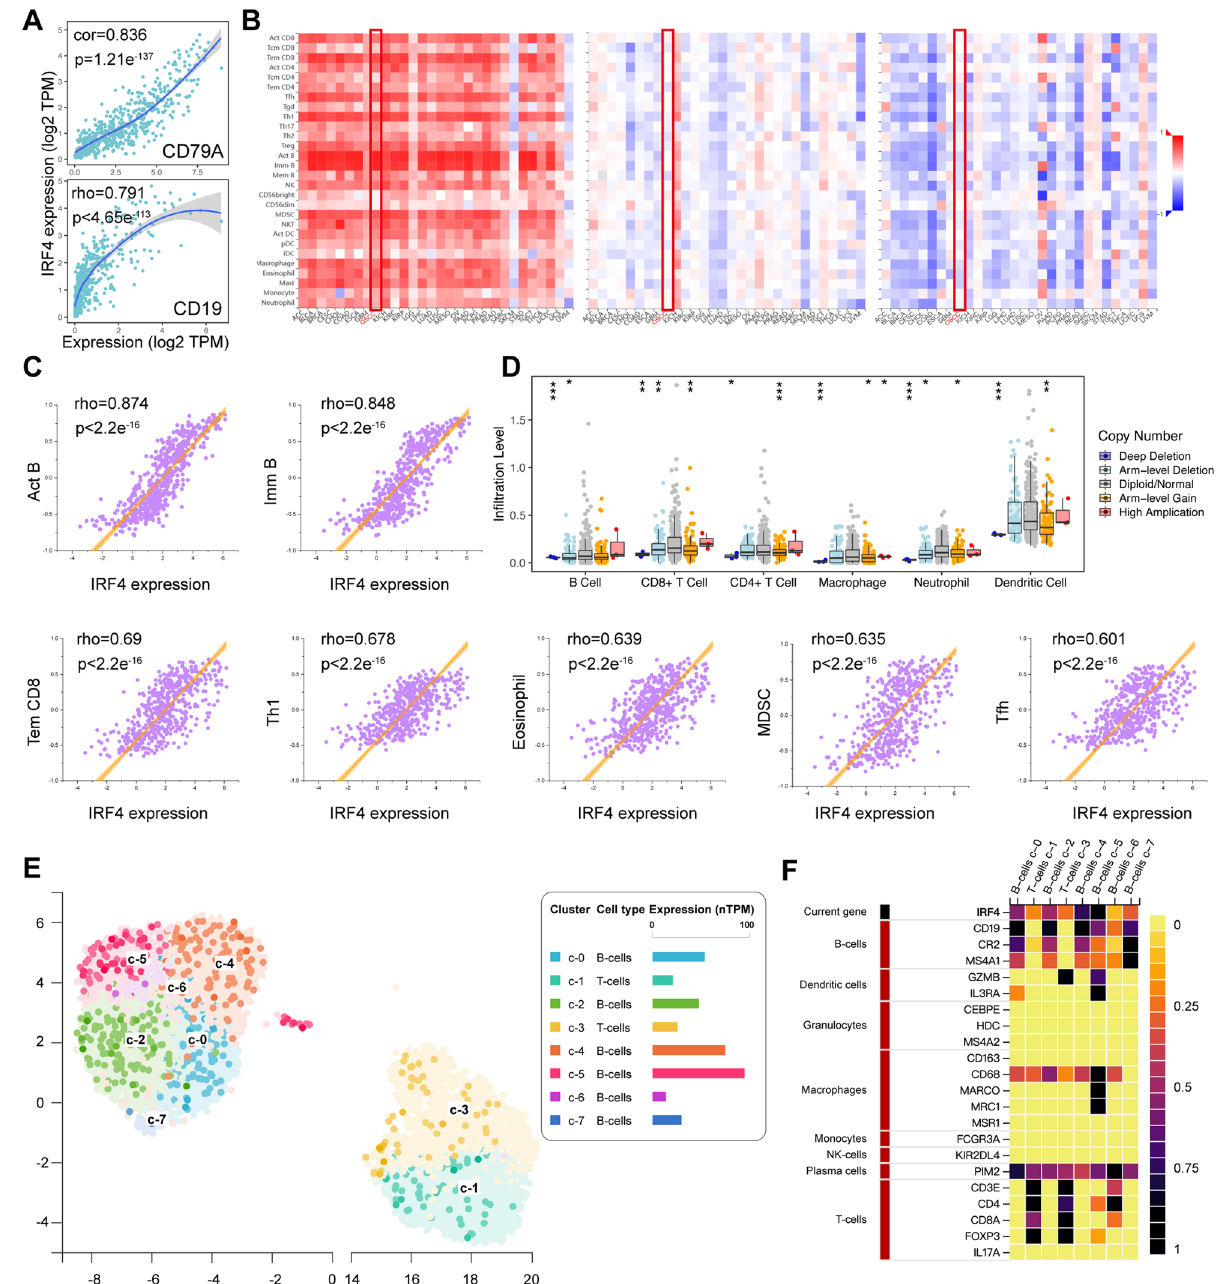
Figure 6. Immune Infiltration Analysis of IRF4 in OSCC. ( A ) The correlation between IRF4 and representative immune genes performed via TIMER. ( B ) The relationship between expression, copy number and methylation of IRF4 and immune infiltration levels in pan-cancer from TISIDB. ( C ) The correlation between IRF4 and multiple immune cells (Pearman’s correlation test). ( D ) The relevance of different somatic copy number alterations for IRF4 and OSCC infiltration levels from TIMER database. ( E ) Expression pattern of IRF4 Single-cell RNA in various immune cell types in lymph node from the human protein atlas. ( F ) The correlation between IRF4 and immune cell type markers from the human protein